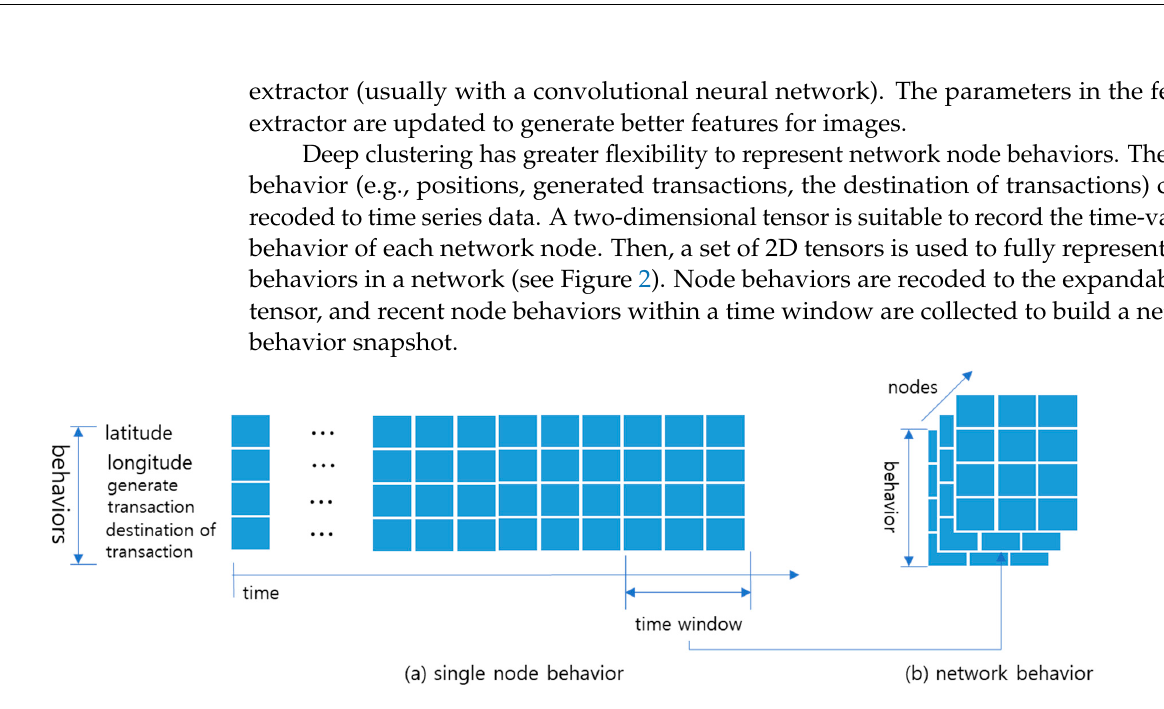
Figure 2. A 2D tensor form presenting node behavior: ( a ) single node behavior; ( b ) network behavior. The feature extractor uses a network behavior snapshot as input data, and a feature vector obtained from the extractor is used to build network node clusters. A standard clustering method, such as k-means, generates clusters. Network clusters provide pseudo labels to their member nodes. The pseudo label is given as a 1D tensor, and the labels of all network nodes are used to evaluate the quality of feature extraction (see Figure 3). The generated features are continuously enhanced by the iterative operation of feature extractor and standard clustering method. The standard clustering method uses the current features and provides pseudo labels for IoT node clustering. The result of node clustering is used to train the feature extractor.